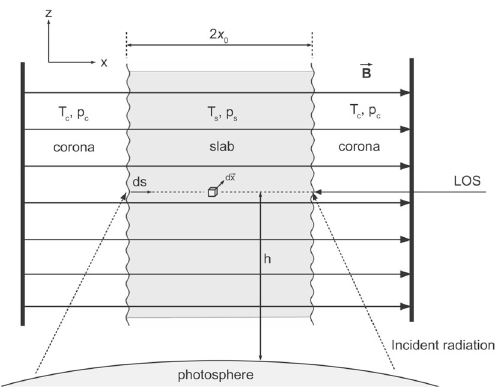
Fig. 59 Sketch of the model used by Zapiór et al. (2016) to compute the H α and H β line profiles arising from linear MHD waves propagating in a prominence. The magnetic field threading the prominence is horizontal and tied at its ends to incorporate the effect of the dense photosphere on